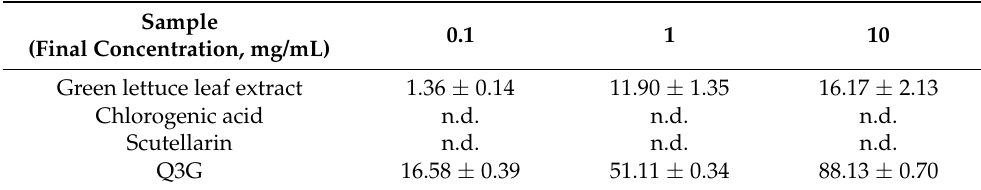
Table 1. Displacement (%) of [ 3 H]-flumazenil binding of green lettuce leaf extract (GLE), chlorogenic acid, scutellarin, and quercetin-3-glucuronide (Q3G) through GABA A -benzodiazepine receptor assay.